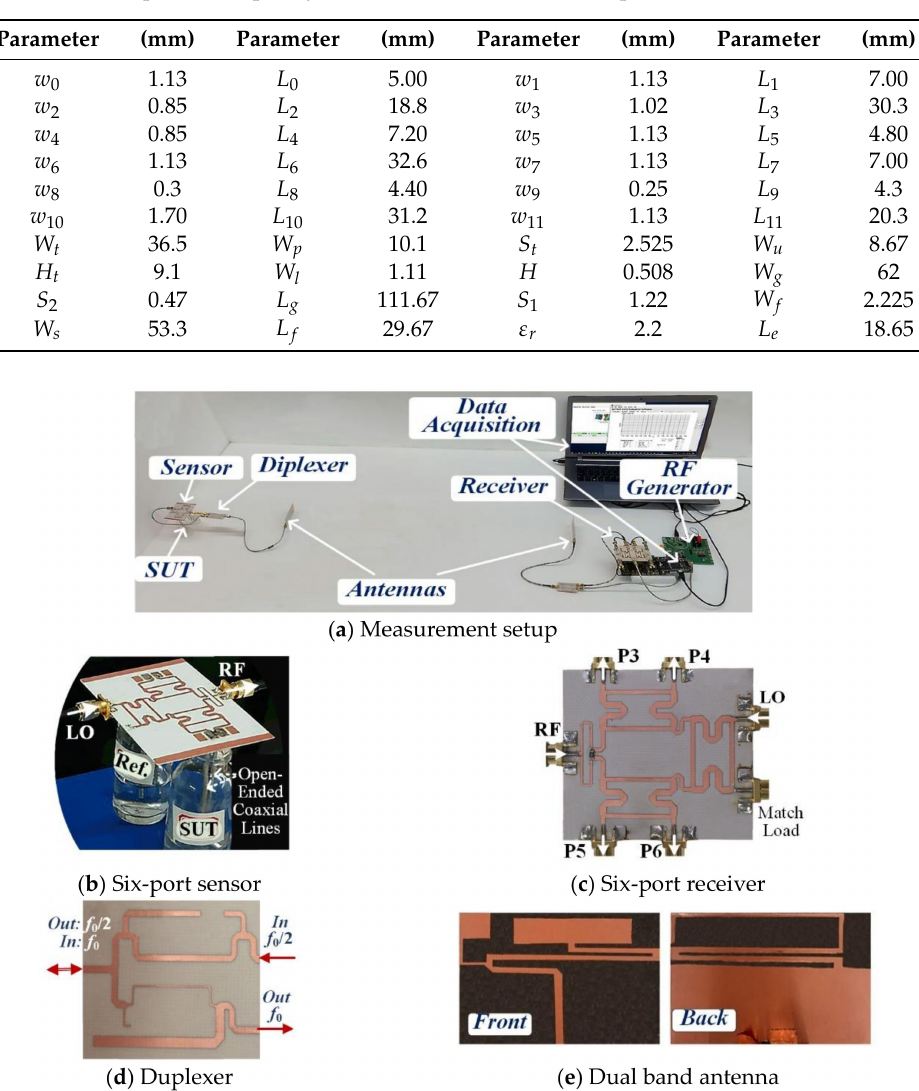
Table 2. Diplexer, Frequency Doubler, and Dual-Band Compact Antenna Dimensions.